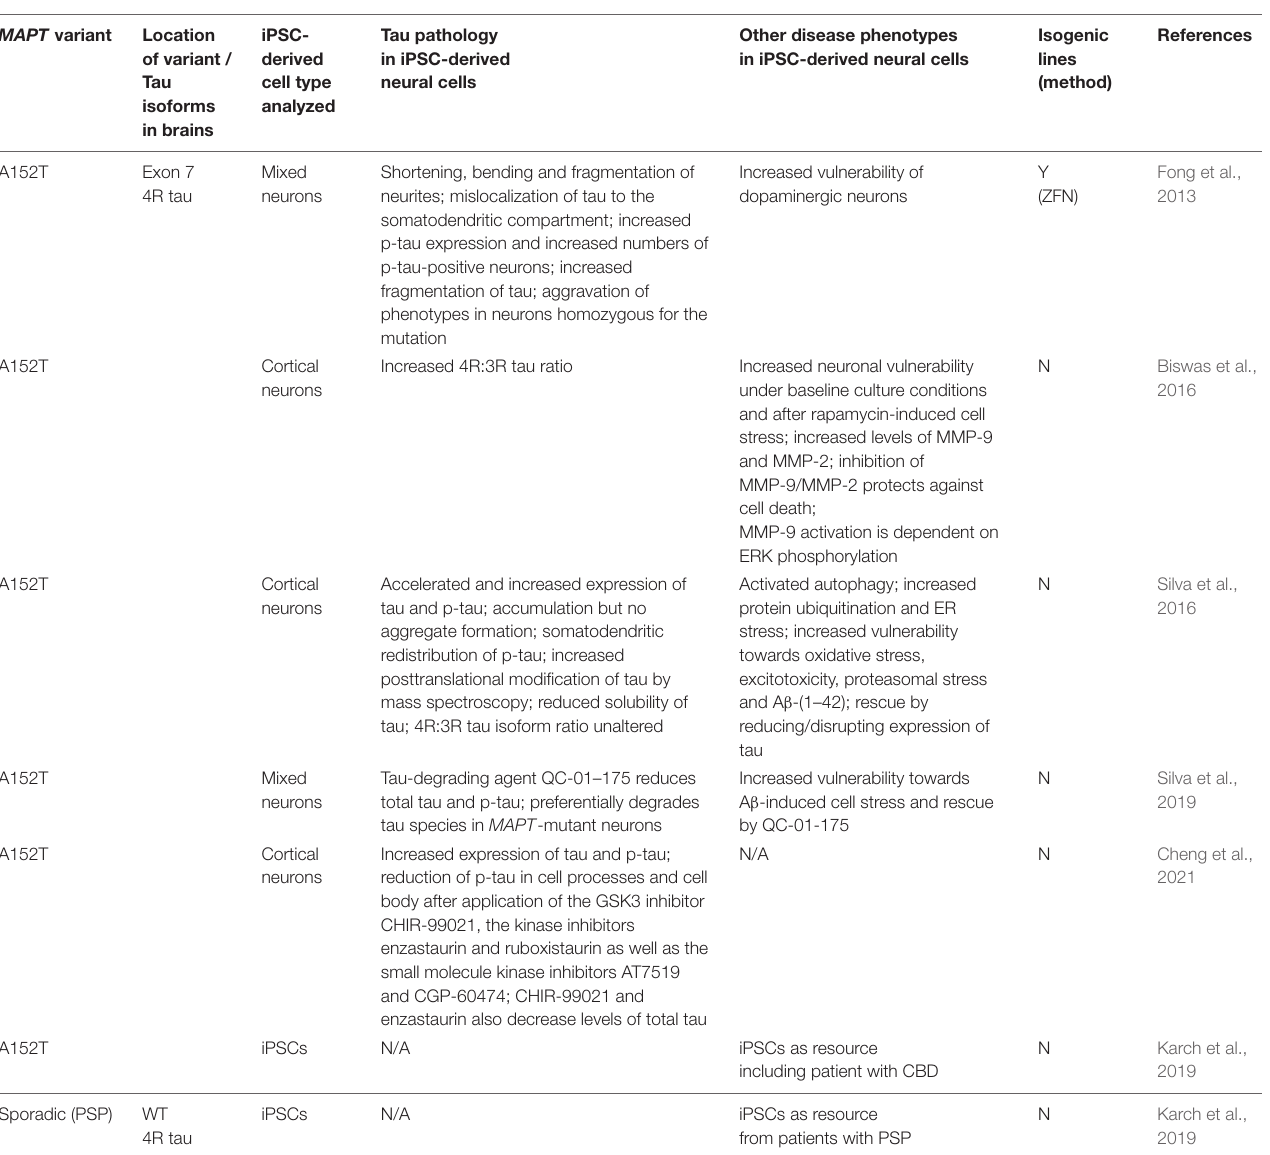
TABLE 4 | Additional induced pluripotent stem cell models of FTLD-tau. MAPT